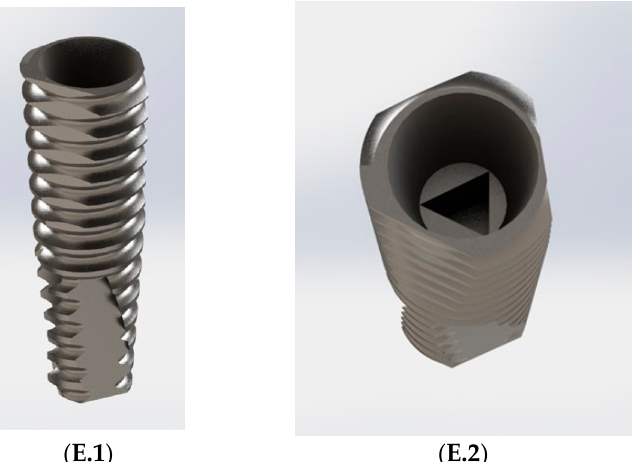
Figure A1. Five models of implant connections: ( A ) External hexagon; ( B ) internal hexagon; ( C ) morse taper; ( D ) conical; ( E.1 ) conical triangular lateral view; ( E.2 ) conical triangular occlusal view.